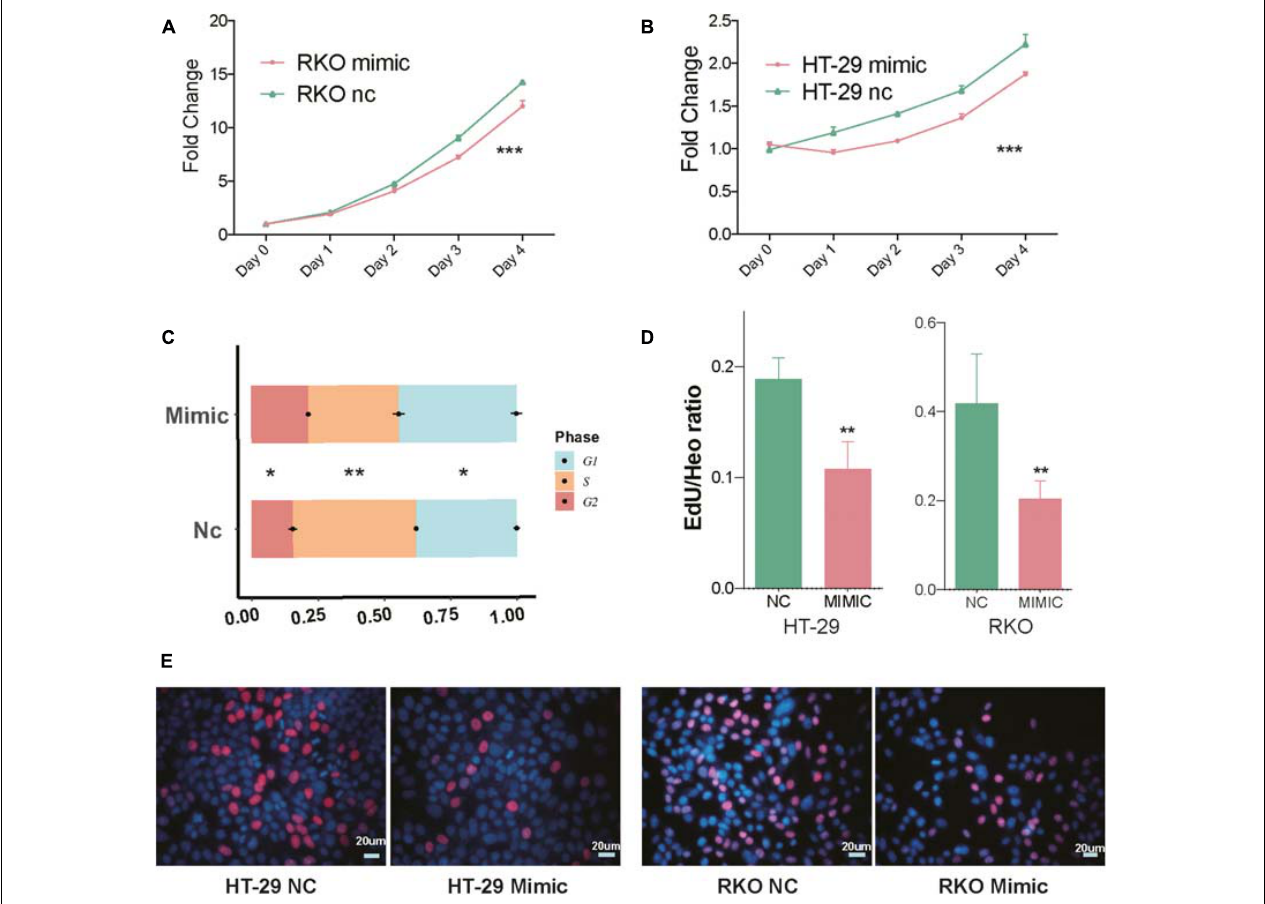
FIGURE 3 | MiR-490-3p inhibits the proliferation of CC cells. (A,B) MTS assays of NC and mimic group showed significantly lower proliferation speed in mimic group. (C) Cell cycle assays showed miR-490-3p induced a significant G1/S arrest. (D,E) Edu assays between NC and mimic group showed miR-490-3p induced lower S phase cells. * P < 0.05, ** P < 0.01, *** P <